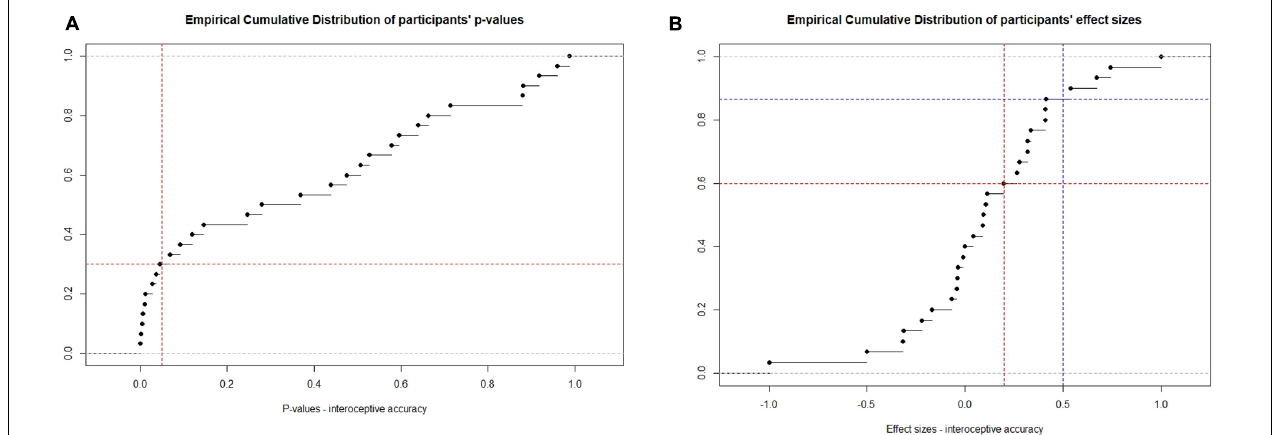
FIGURE 2 | Empirical cumulative distribution (ECD) of (A) p -values obtained after comparing the Mann–Whitney U statistics against the population of reference and (B) effect sizes. (A) Red line vertical = 0.05, horizontal = 0.05 of the ECD; (B) Red line vertical = 0.2 (small effect size), horizontal = 0.2 of the ECD; Blue line vertical = 0.5 (medium effect size), horizontal = 0.5 of the ECD. Gray lines: upper and lower boundaries of p -values.